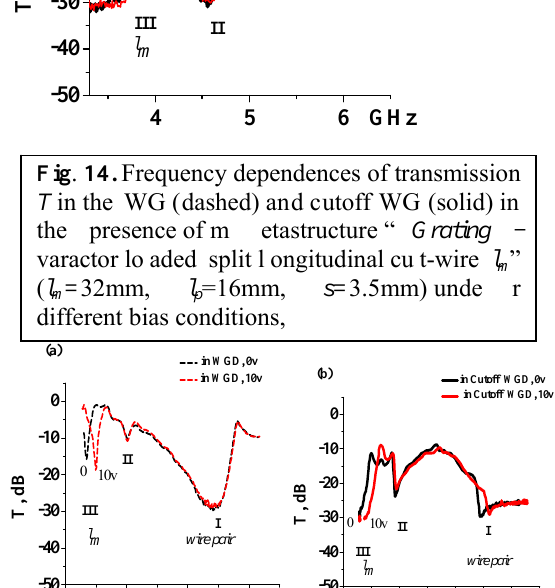
In the case of using two wires with different lengths l e1 and ER s ( ER ER l e2 two 1 and 2 ) a re e xcited at di fferent frequencies an d t wo pass-bands (in cut off WG) a ppear bellow resonances ER that are characteristics of the electric excitation ( Fig. 12 ).